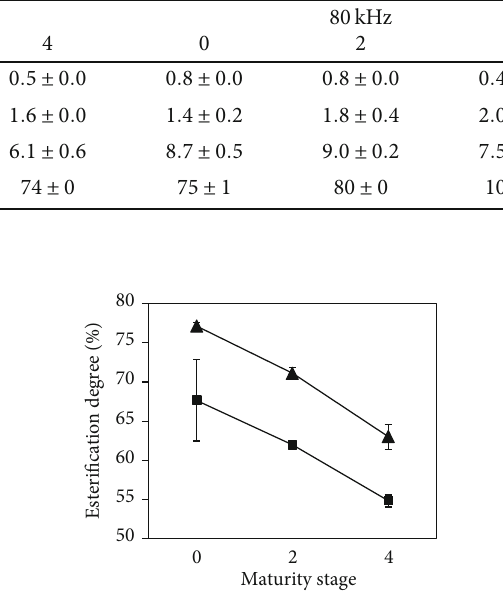
Figure 3: Degree of esteri fi cation of extracted pectin after 20 min in relation to maturity stage (0, 2, and 4) at 37kHz ( ▲ ) and 80 kHz ( ■